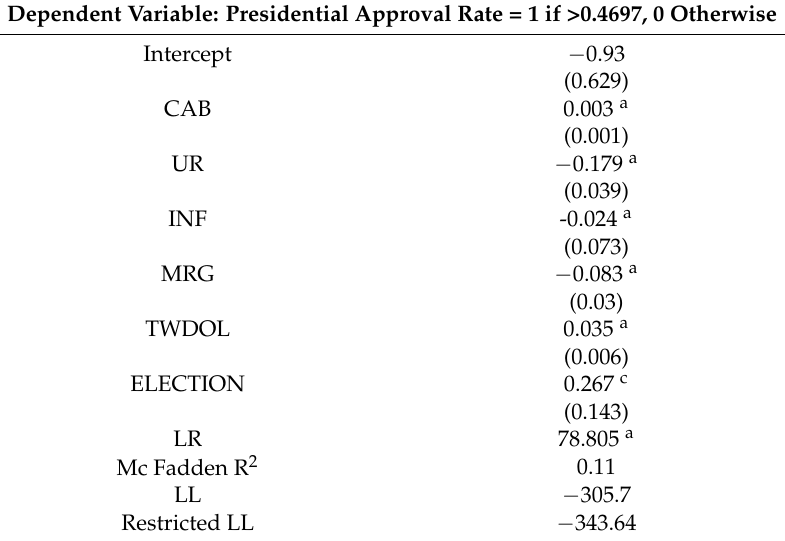
Table 2. Maximum Likelihood estimation of the Probit